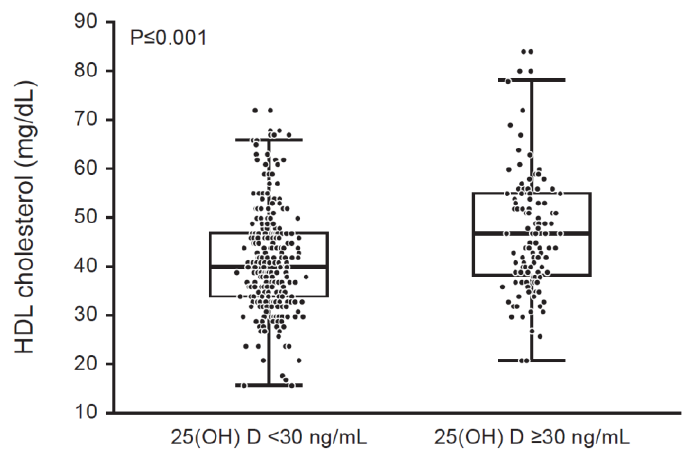
Figure 1. Box-plot showing differences in high-density lipoprotein (HDL) cholesterol between children with 25(OH)D < 30 ng/mL and those with 25(OH)D ≥ 30 ng/mL ( p < 0.0001).